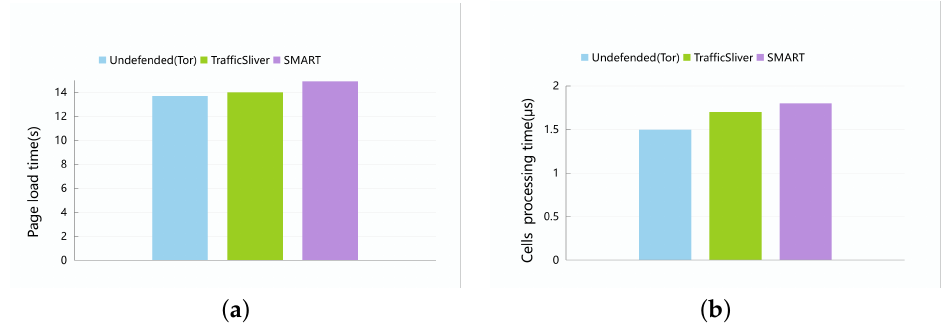
Figure 10. Time overhead: ( a ) page load time; and ( b ) cell processing